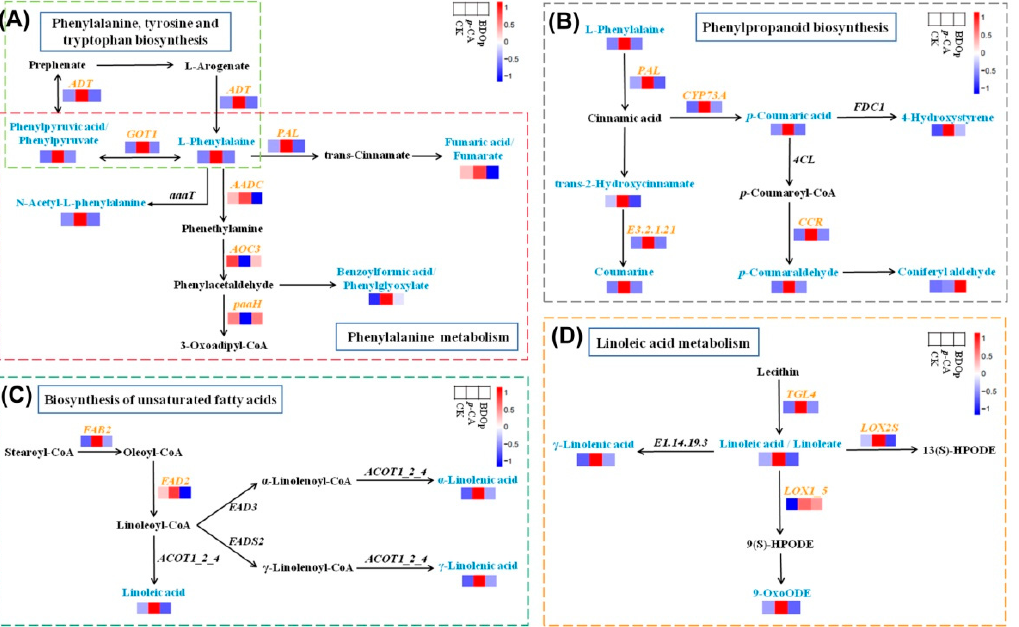
Figure 8. Visual analysis of the network of phenylpropanoid biosynthesis ( A ), phenylalanine metabolism ( B ), biosynthesis of unsaturated fatty acids ( C ), linoleic acid metabolism ( D ) for the CK, p -CA stress treatment, and BDOp treatments. (CK, ddH 2 O control group; p -CA, treatment group with 10 mL 400 mg/L p -coumaric acid; BDOp, p -coumaric acid with biochar-dual oxidant particles.).